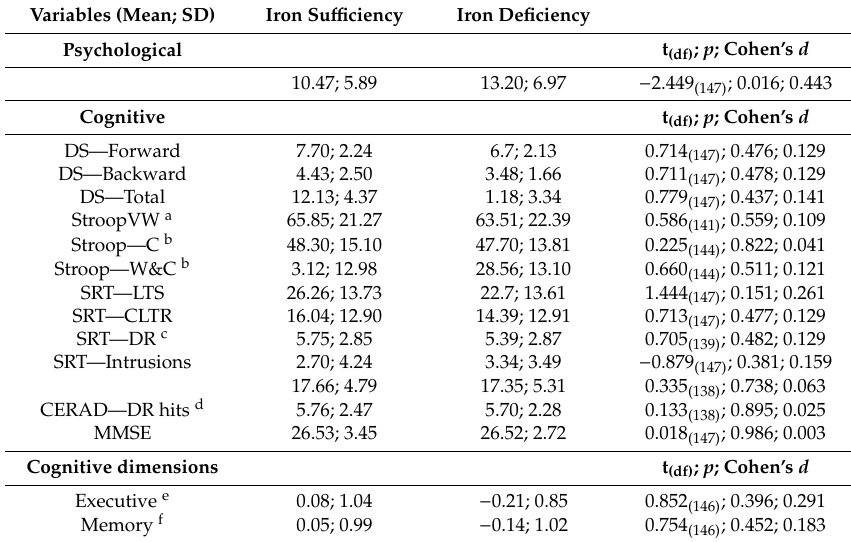
Table A1. Psychological and cognitive characteristics of participants and di ff erences by group of iron status.